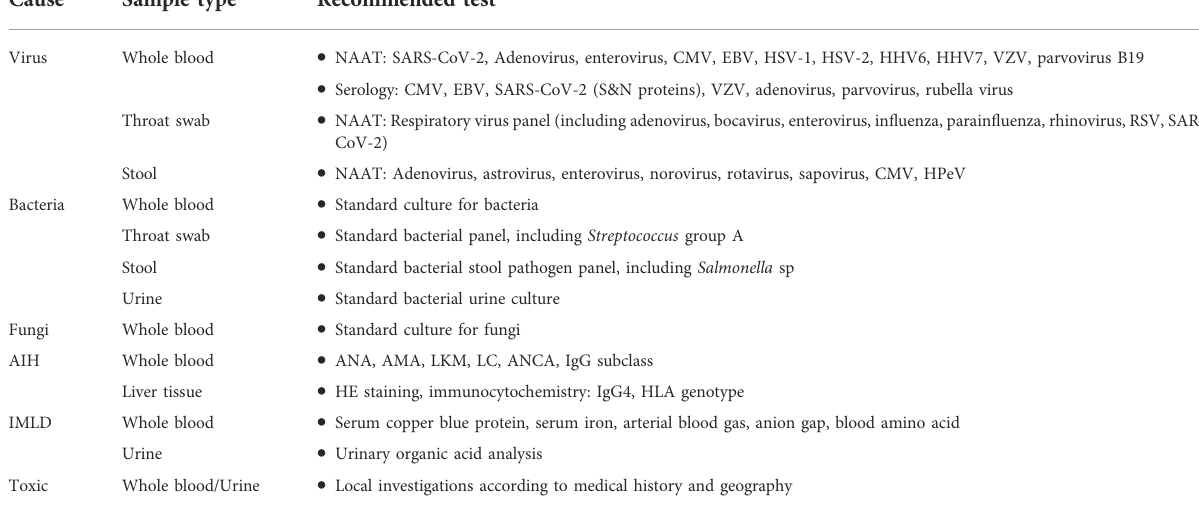
TABLE 3 Laboratory testing in acute hepatitis of unknown origin in